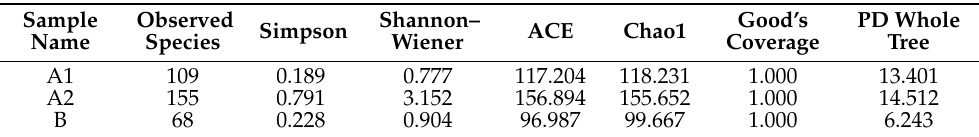
Table 1. Alpha diversity indices.